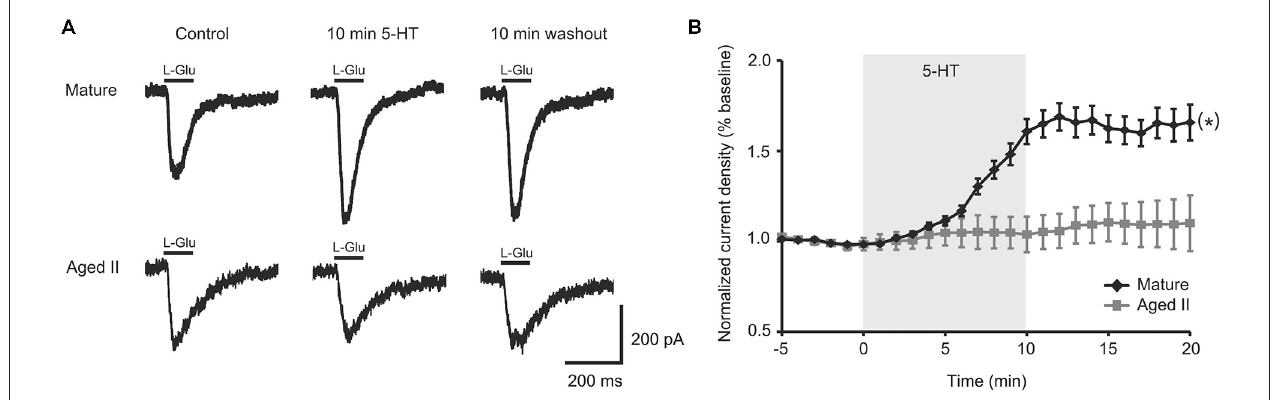
FIGURE 1 | 5-HT-induced facilitation of L-glutamate (L-Glu) currents was present in mature tail sensory neurons (SN), but absent in aged II tail SN. (A) Representative currents evoked in response to 100 ms pulse of L-Glu in isolated SN before 5-HT, after 10 min 5-HT, and after 10 min washout of 5-HT. (B) While current density increased significantly following 5-HT treatment in isolated SN from mature animals, no change was observed in aged II SN. ( ∗ ) denotes significant overall increase in current density at p ≤ 0.05 via repeated measures ANOVA ( n = 16 for mature, n = 20 for aged II). Post hoc comparisons responsible for this difference are summarized in results.